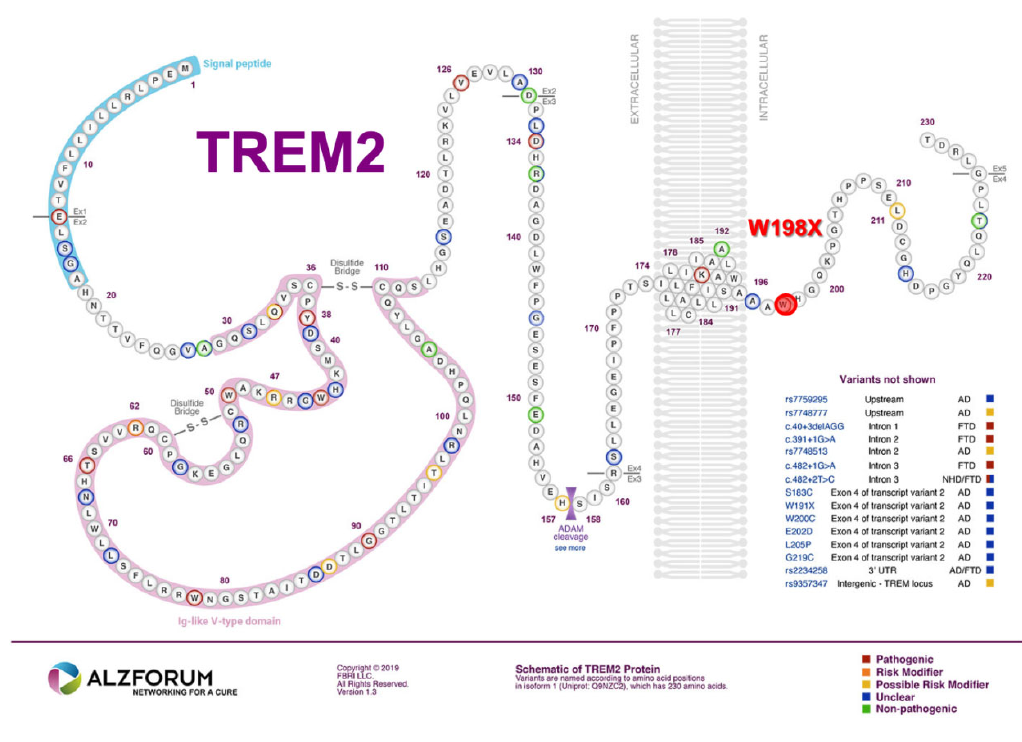
TREM2: triggering receptor expressed on myeloid cells 2. Figure 4. Latin American triggering receptor expressed on myeloid cells 2